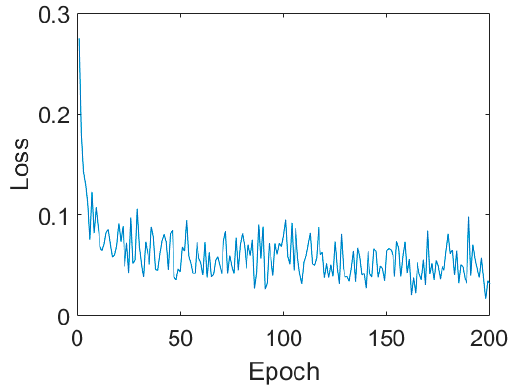
Figure 8. Loss curves on Oberpfaffenhofen dataset.